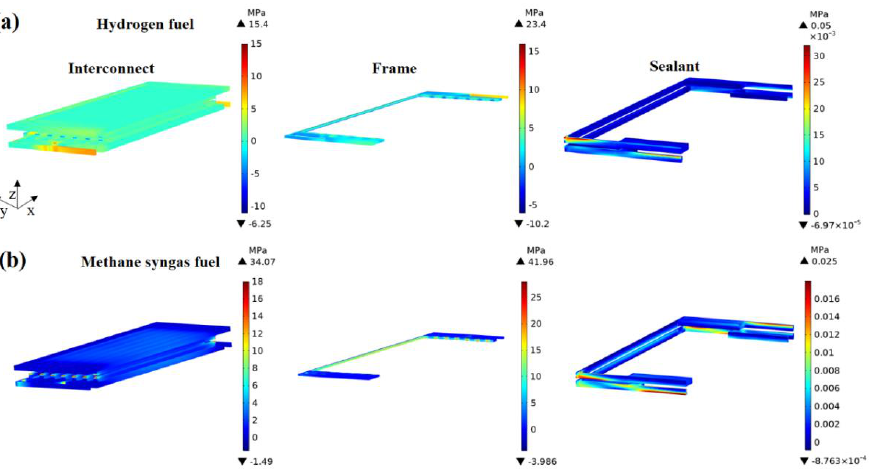
Figure 9. Thermal stress of the assembly components for: ( a ) hydrogen fuel; ( b ) methane syngas fuel.